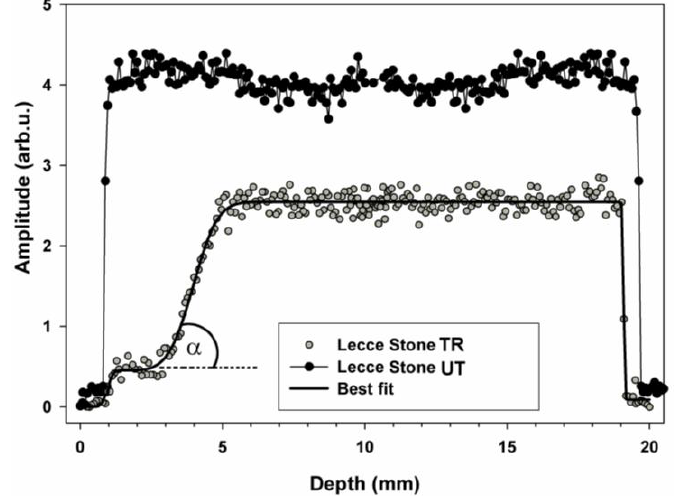
Figure 8. Depth profiles of untreated Lecce stone (UT), and Lecce stone treated with HDDA polymerized in situ (TR) obtained after making specimens absorb water by total immersion. The solid line through experimental points was obtained fitting the profile to Equation (3).